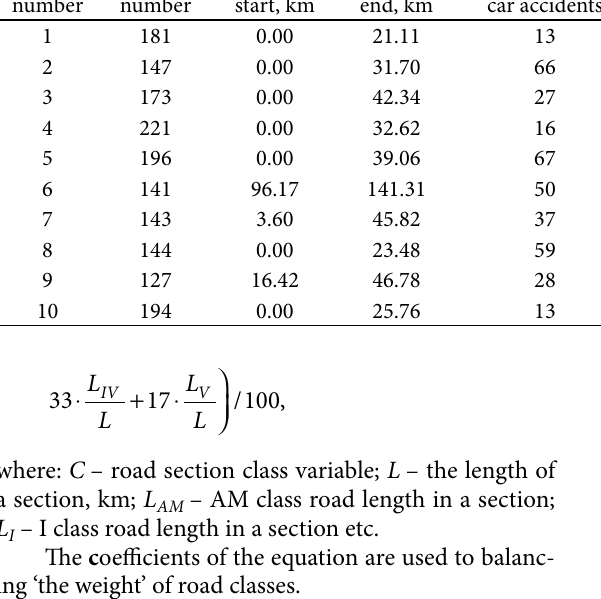
Table 5. Top 10 road sections with the highest risk of a valid car accident per car on Lithuanian main and interurban road networks in the years 2002–2006 Running Road number number